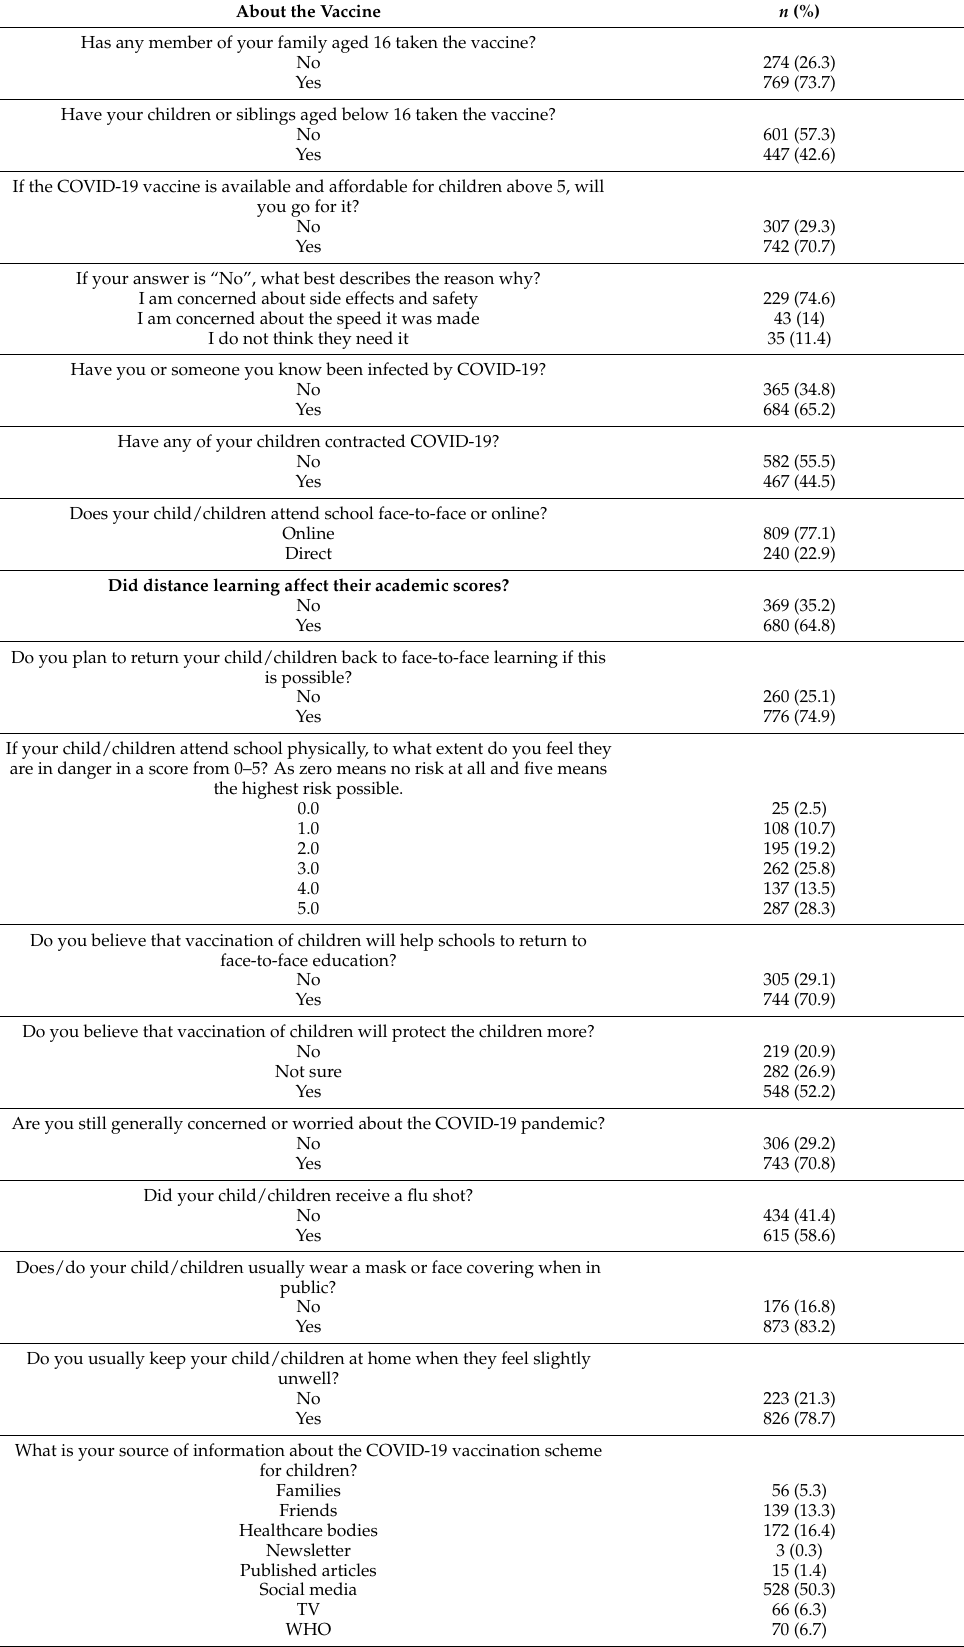
Table 2. Parents’ perspectives towards COVID-19 vaccine ( n =